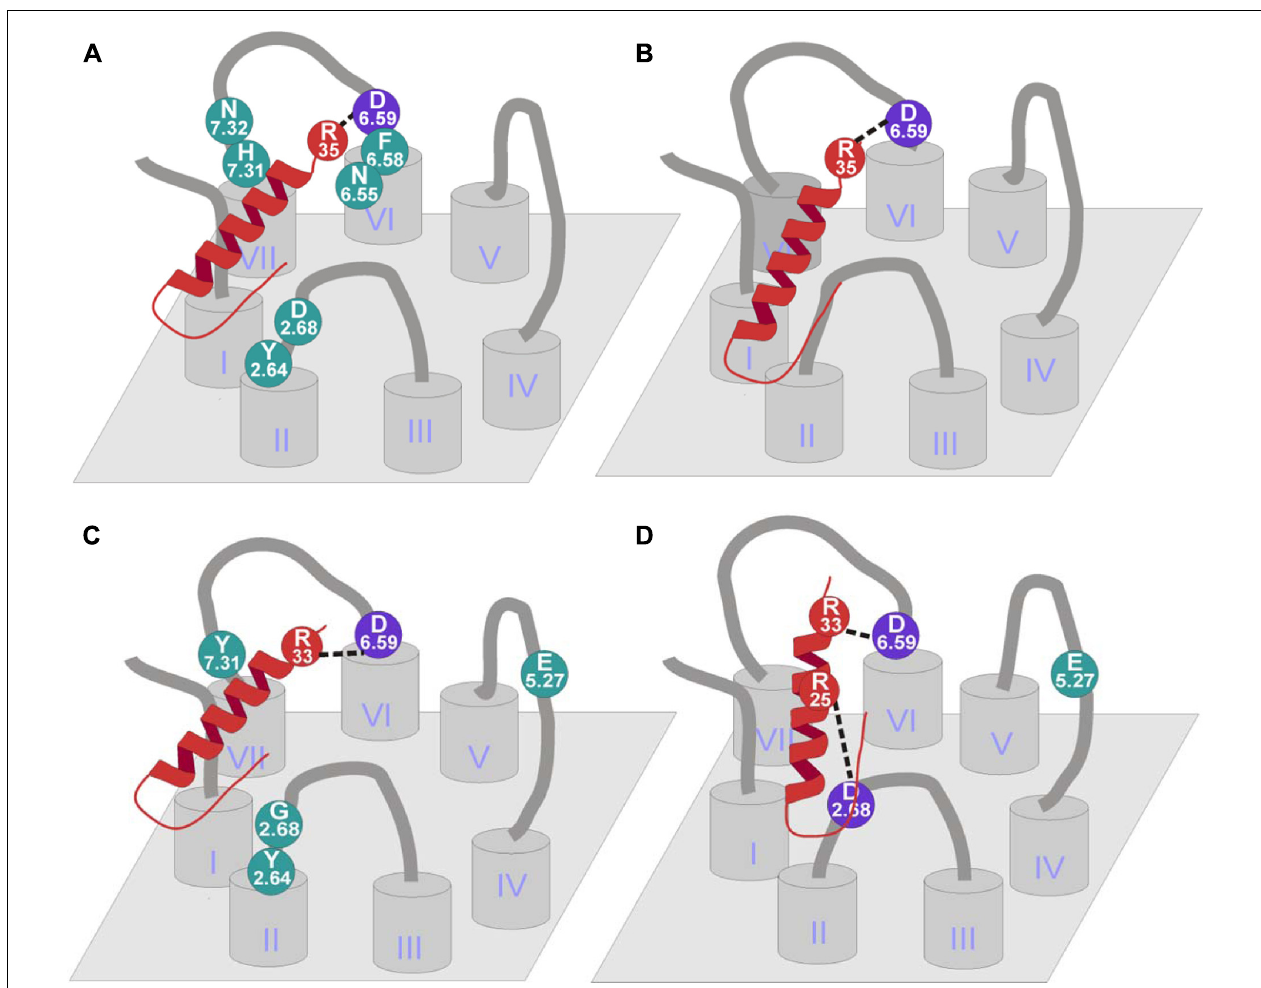
FIGURE 6 | Binding mode of NPY receptors. (A) hY 1 receptor binding mode (Sautel etal., 1995, 1996; Kannoa etal., 2001; Sjodin etal., 2006; Merten etal., 2007); (B) hY 4 receptor binding mode (Merten etal., 2007); (C) hY 2 receptor binding mode (Merten etal., 2007; Akerberg etal., 2010); (D) hY 5 receptor binding mode (Merten etal., 2007; Lindner etal.,